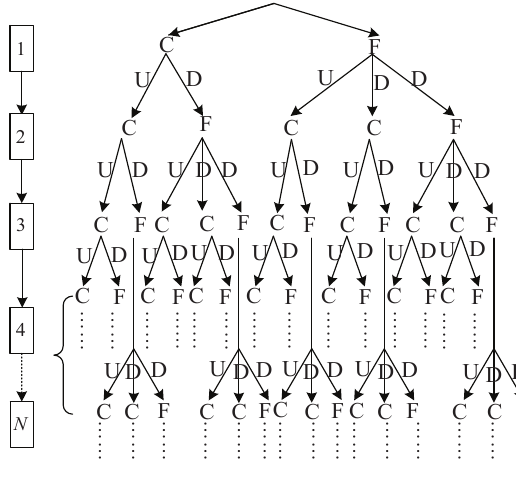
Figure 4. Combination